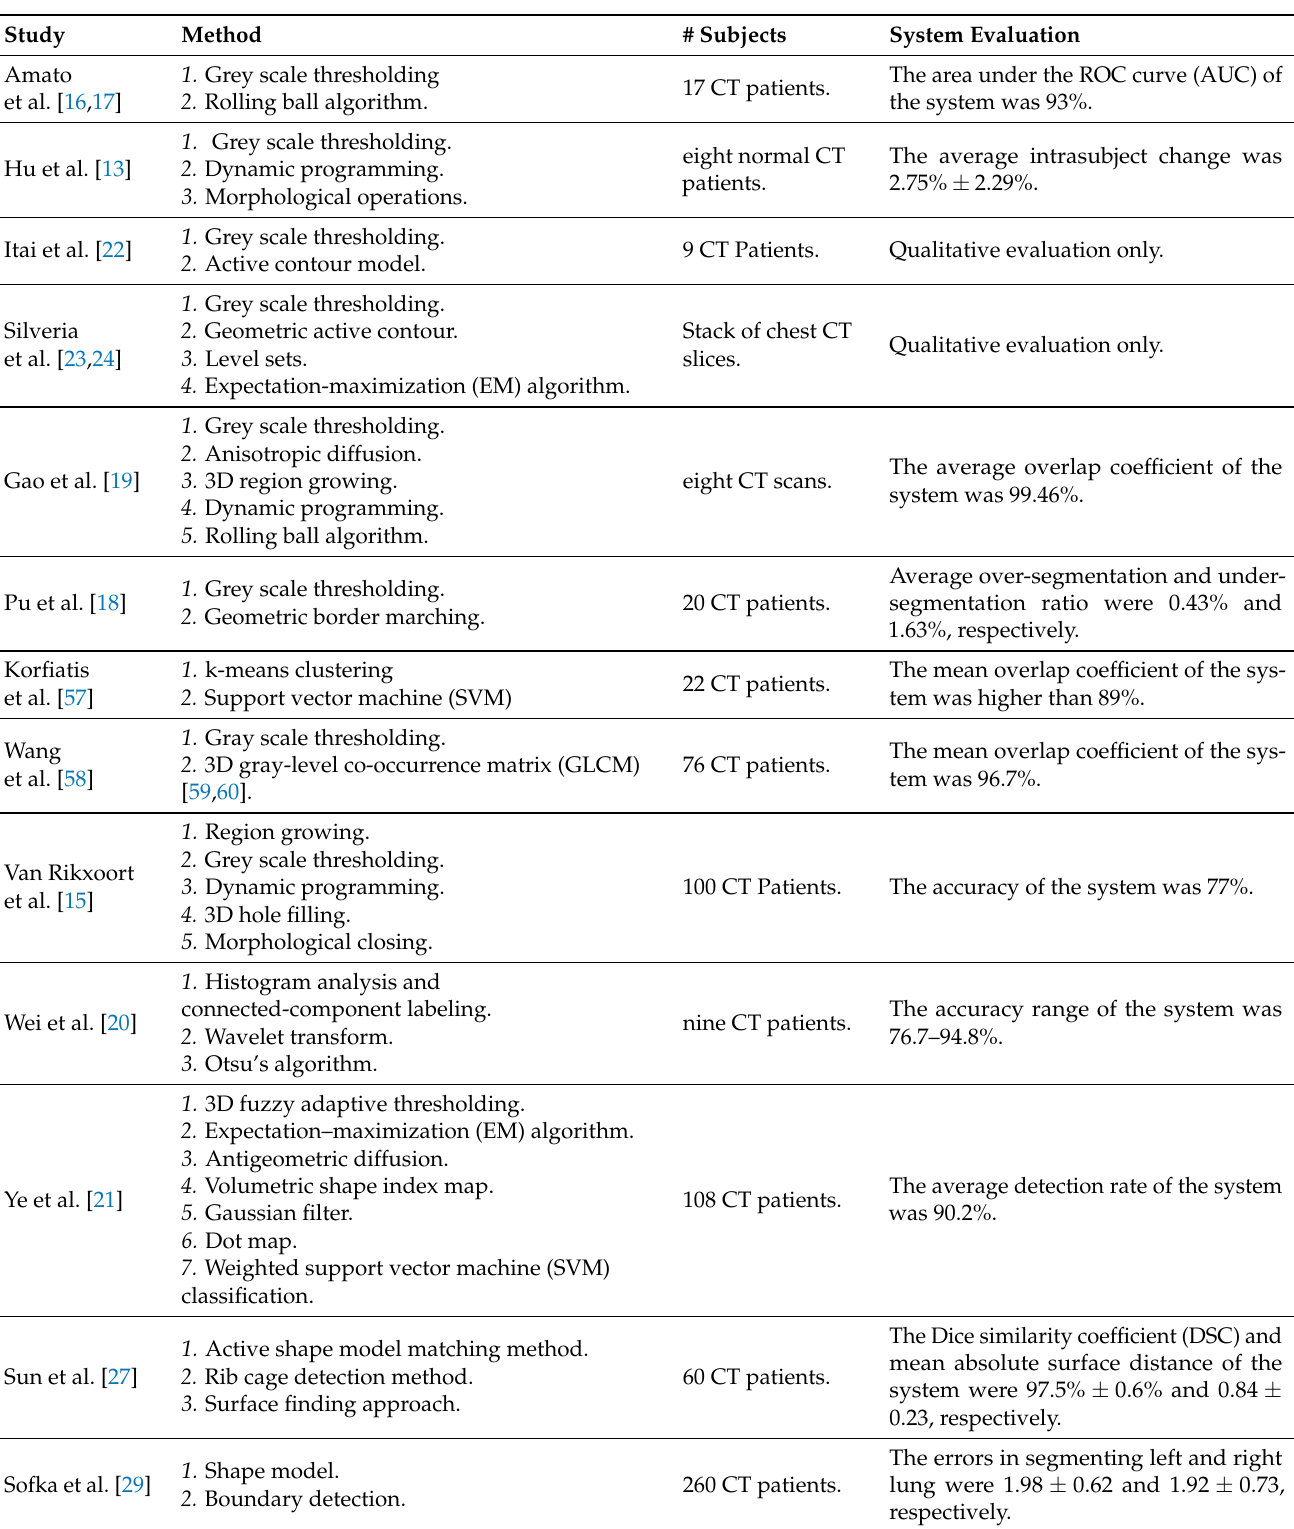
Table 1. Literature reviews of lung segmentation system using Hounsfield unit (HU) threshold, deformable boundaries, shape models, region/edge-based models, or machine learning (ML)